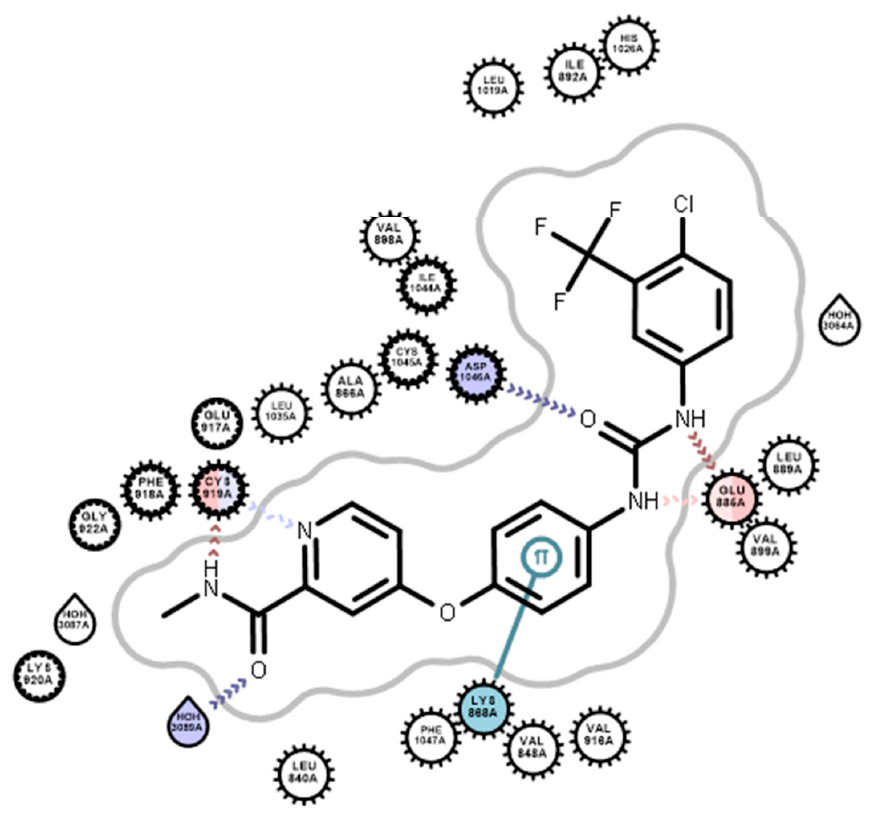
Figure 1. Basic pharmacophoric features of sorafenib (PDB ID: 3WZE).